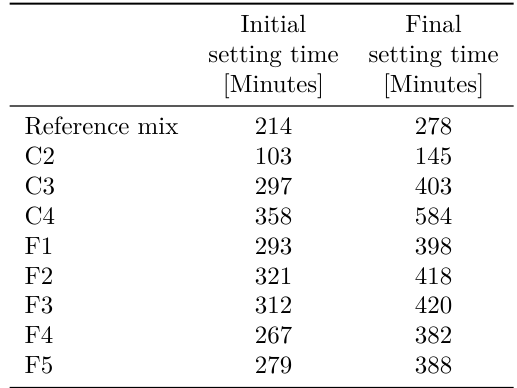
concrete mixtures with maximum aggregate replace-